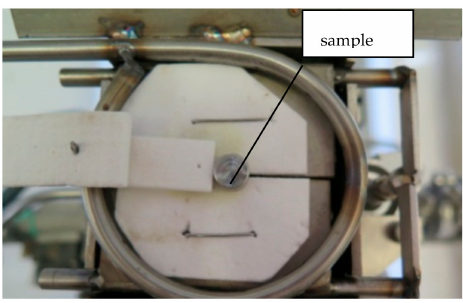
Figure 2. Sample placed on the heating table. The latches open at the desired temperature, and the sample falls into the quenching medium.